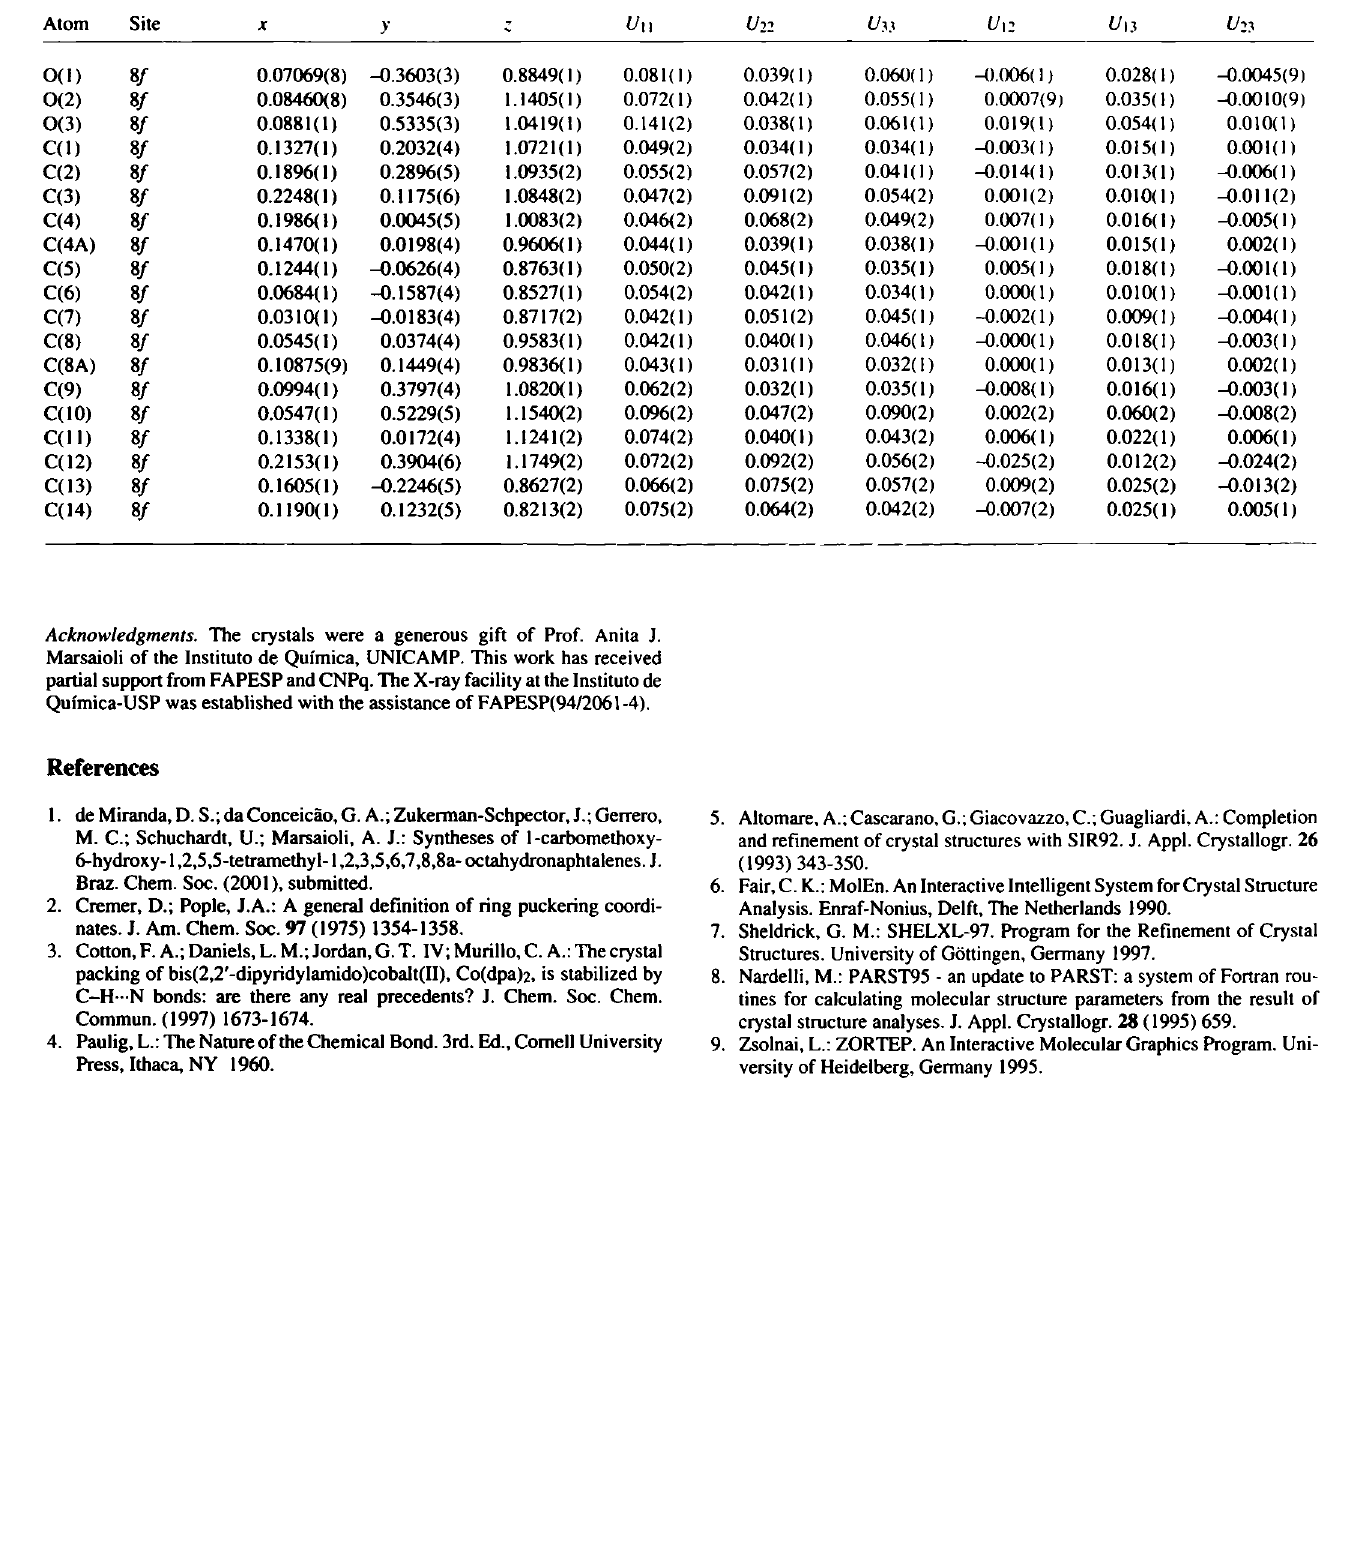
Table 3. Atomic coordinates and displacement parameters (in A 2